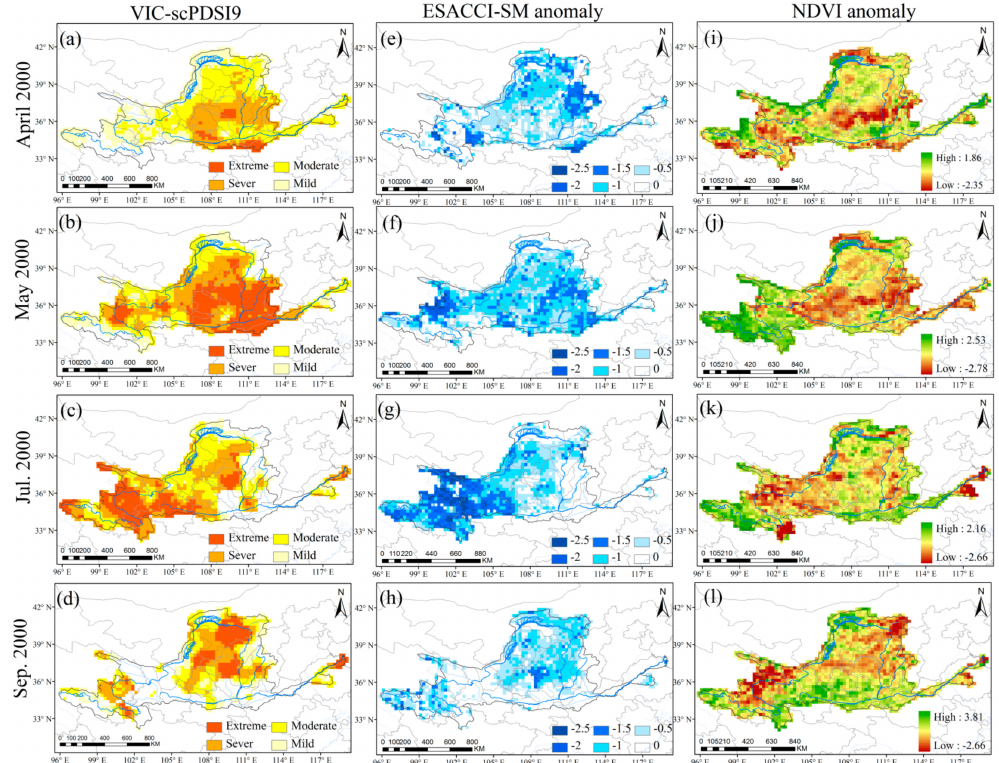
Figure 12. Spatial evolution of the 2000 drought indicated by ( a – d ) VIC-scPDSI9, ( e – h ) ESACCI anomaly, and ( i – k ) NDVI